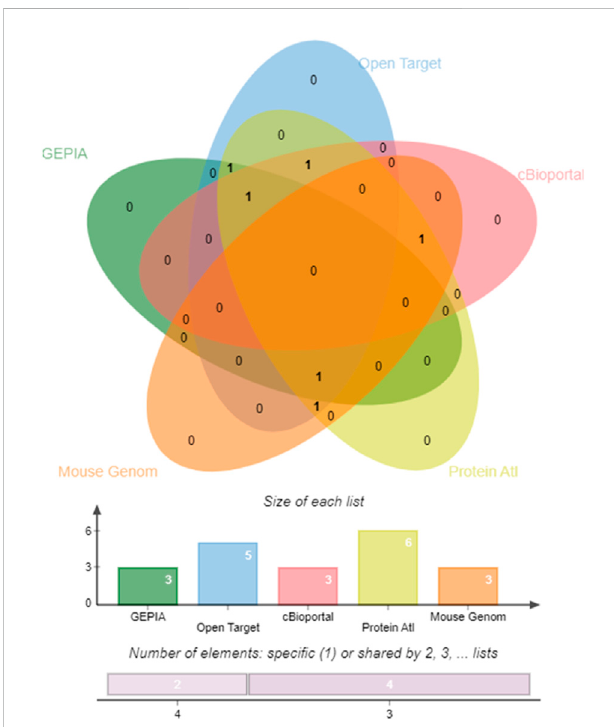
FIGURE 8 Edwards ’ Venn diagram. Prioritizing the impactful hub genes through the system biology methodology of the pooled signi fi cant outcome from 5 functional element analyses. A Venn diagram depicting the overlap of six genes. Horizontal Bar Graph represent the number of hub genes supported by individual functional elements, The Vertical Bar Diagram represent the evidence from four elements for two genes, and three elements for four